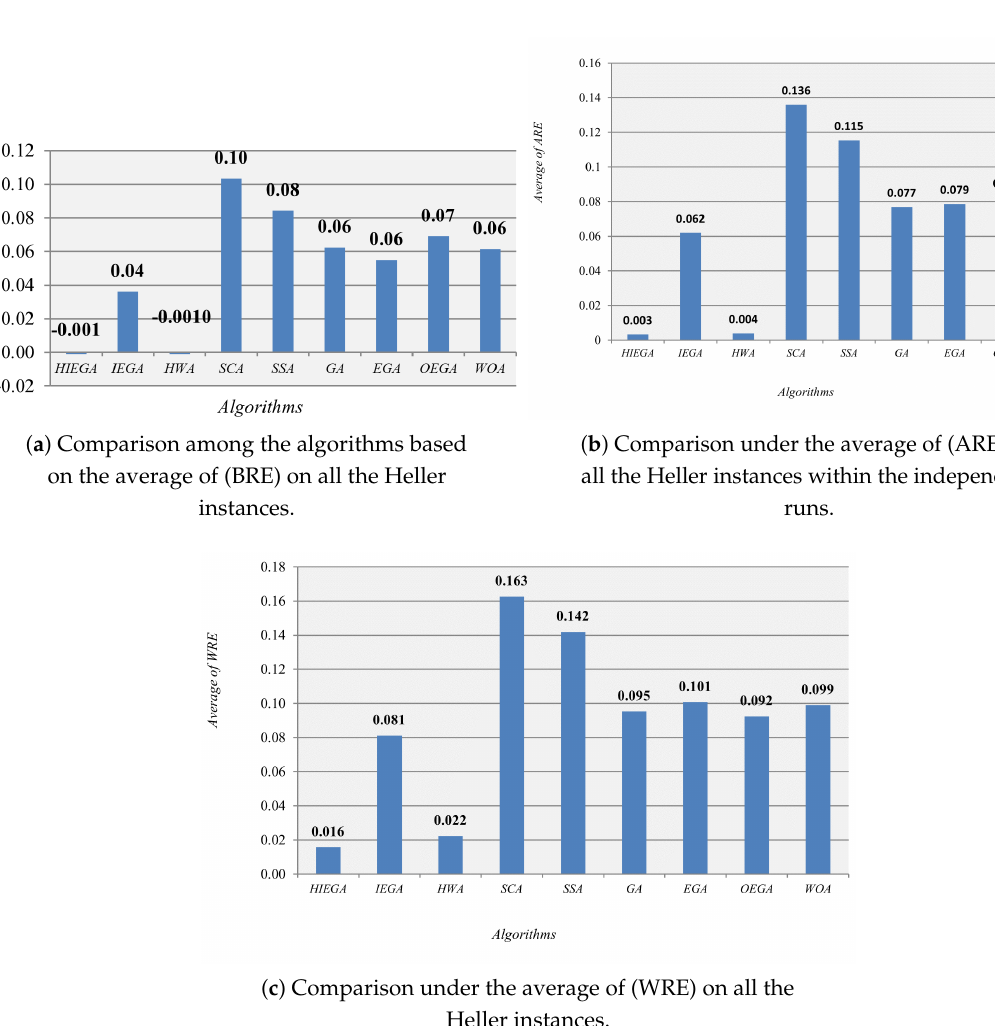
Figure 6. Comparison among algorithms on the Heller